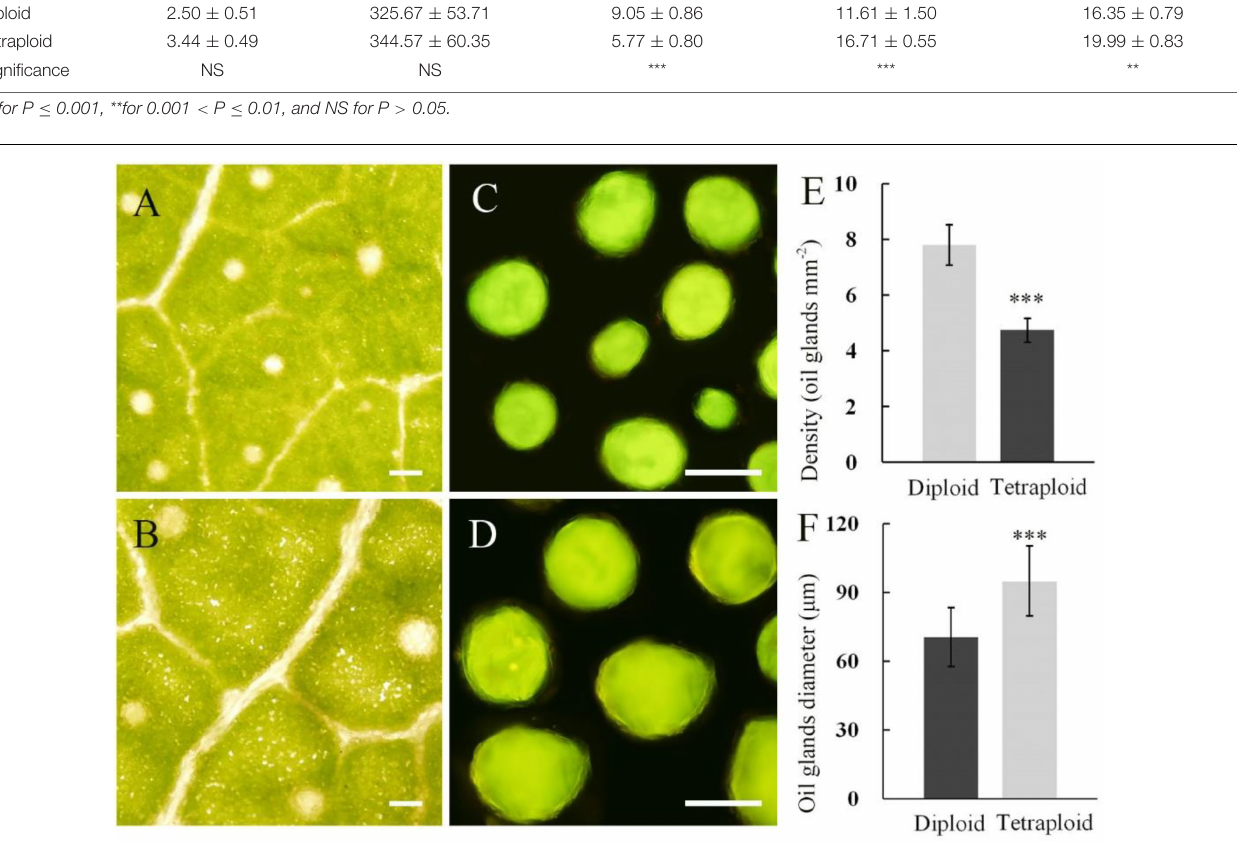
FIGURE 6 | Oil gland characteristics of E. urophylla tetraploids and diploids. Oil glands in the leaf of diploid (A) and tetraploid (B) ; oil glands isolated from the diploid (C) and tetraploid (D) leaf; (E) for measurements of oil gland density; and (F) for measurements of oil gland diameter (bar = 100 µ m). ***for P ≤